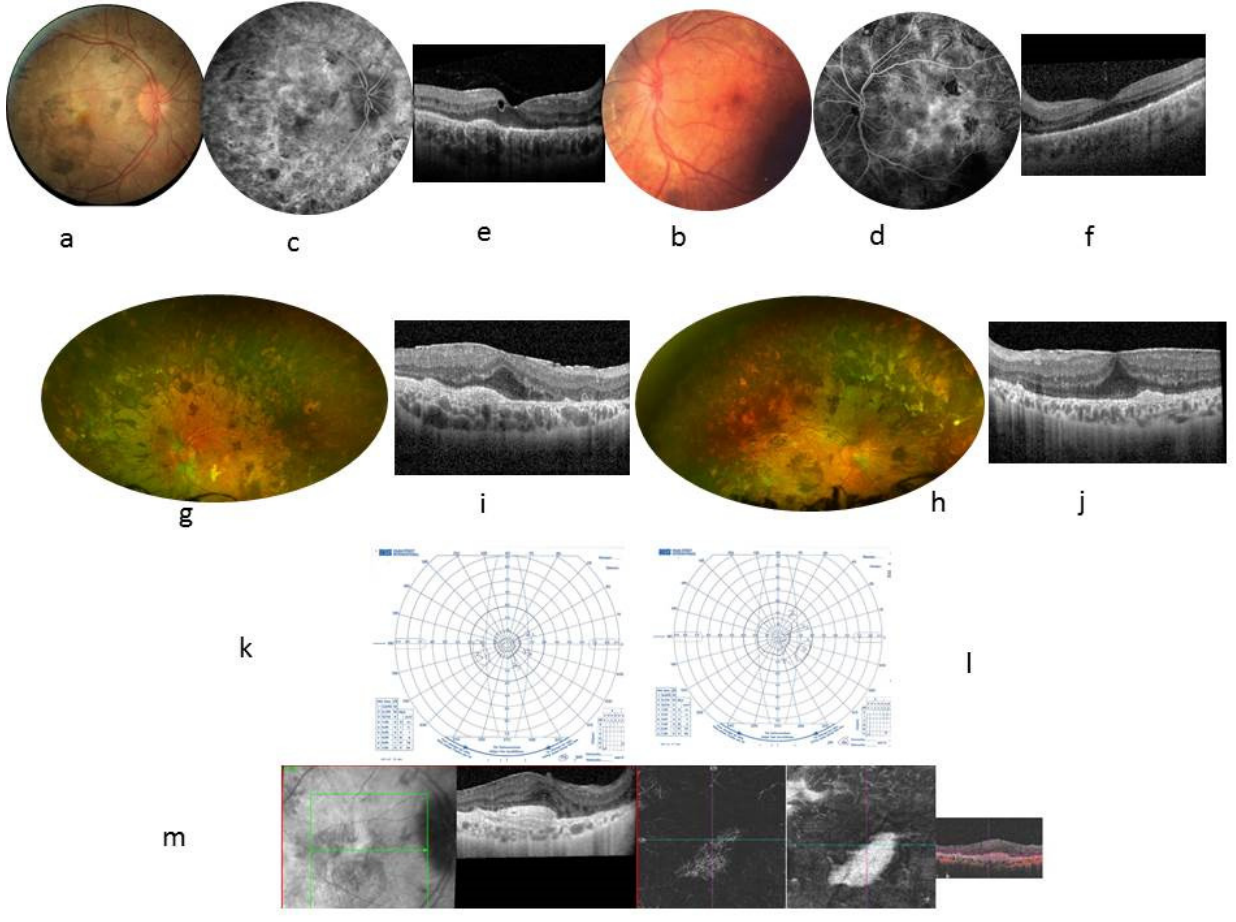
Figure 1. Case 1. 24-year-old woman. BCVA at 20/32 in both eyes. Color fundus photographs showing many pigmentary changes ( a , b ), vascular leakage at the posterior pole on FA at 10 min ( c , d ), and a macular thickening seen in central foveal horizontal scan ( e , f ) showing a central foveal thickness (CFT) at 272 µ m in the RE and 259 µ m in the LE, with presence of cysts within the inner nuclear layer and external plexiform layer adjacent to the papilledema; the external retinal layers are not visible but the external limiting membrane remains visible in the retrofoveolar area. The mean thickness of the retinal nerve fiber layer (RNFL) was 290 µ m in the RE and 333 µ m in the LE. At the age of 30, fundus examination showed an accentuation of the pigmentary changes in the periphery ( g , h ). Autofluorescence photographs showed a few hyperautofluorescent punctuate lesions scattered in the posterior pole ( i , j ). A central foveal horizontal OCT scan found the CFT had increased to 394 µ m in the RE and 414 µ m in the LE, whereas the ellipsoid line was not visible within a thickened RPE, associated with an epiretinal membrane. The VF worsened and became tubular ( k , l ). RE showed pre-epithelial choroidal neovascularization, as seen in the angio OCT × 20 magnification ( m